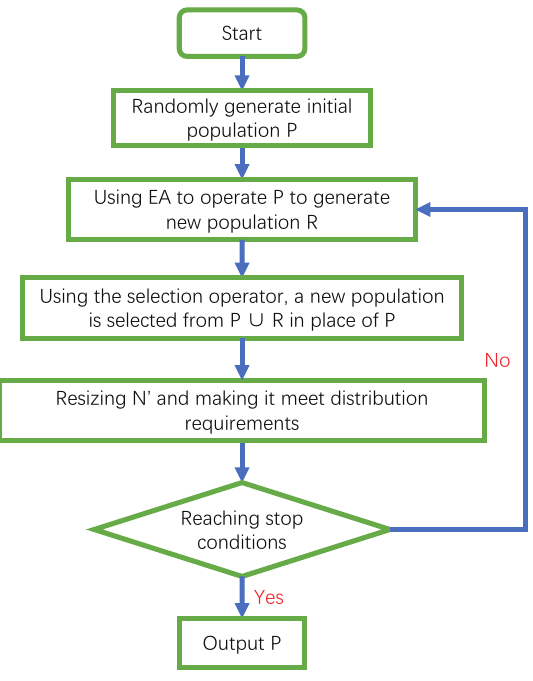
Figure 1. The basic flow of Pareto-based MOEA. The optimal set of solutions from the previous generation is retained and added to the new generation so that it continues to converge to the true Pareto front. This figure is adopted from